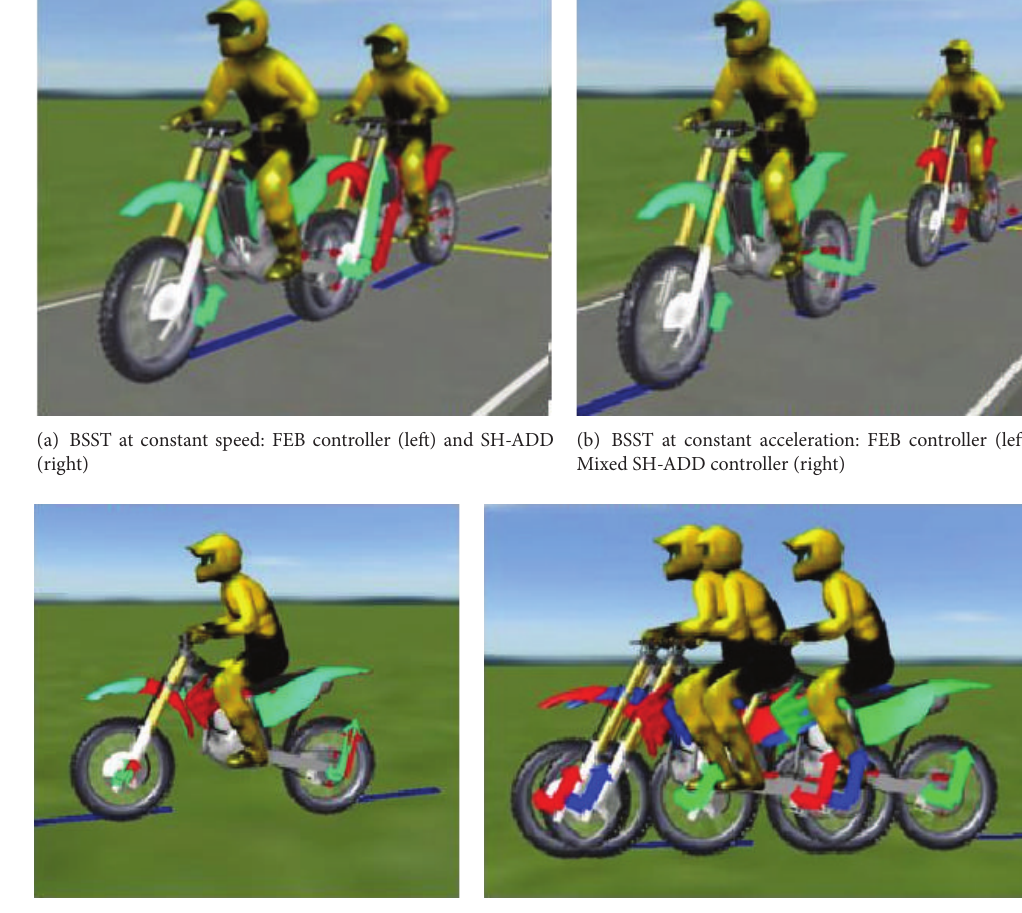
Figure 6: Motorcycle with different semiactive